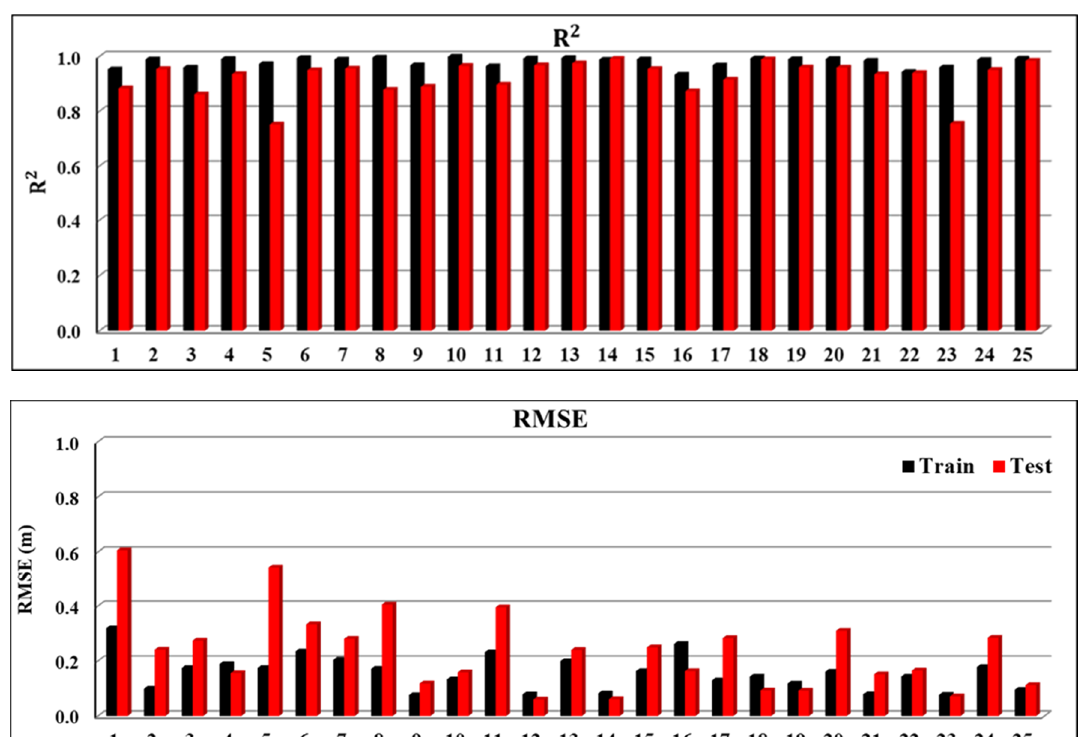
Figure 11. Results of GWL-simulation in all 25 wells (see Figure 2).